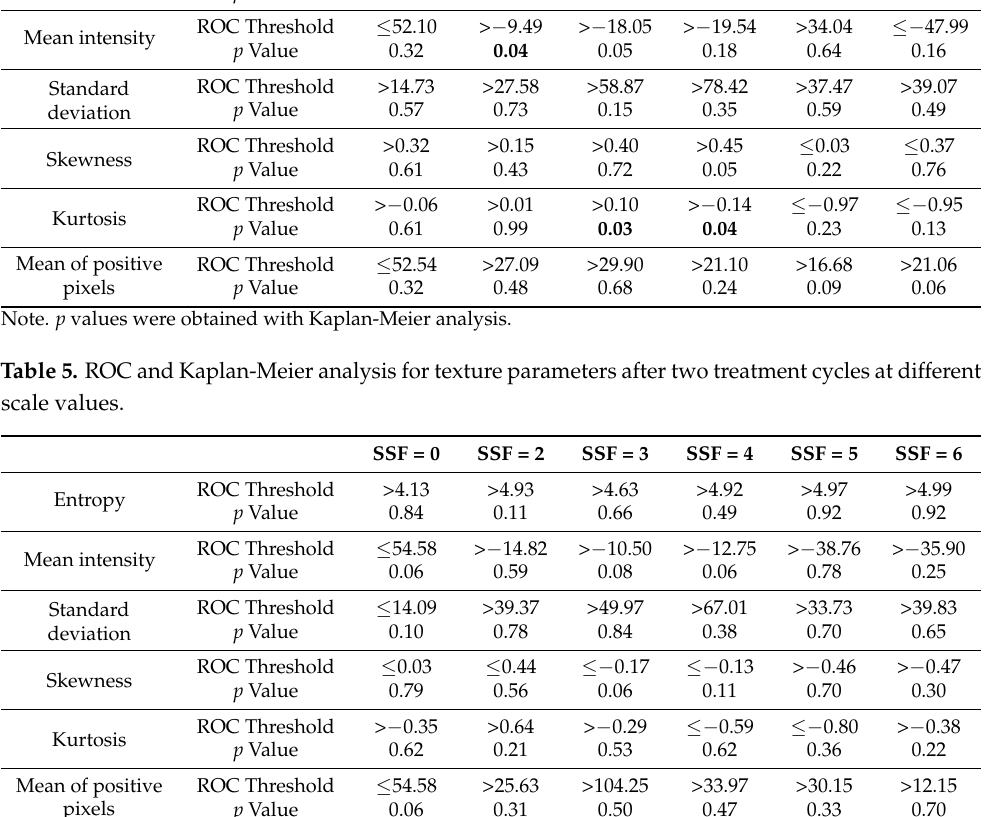
scale (SSF2, p value = 0.033 and p value = 0.016, respectively), and percentage change in MPP at medium texture scale (SSF4, p value = 0.016) were found to be independent prognostic factors for TTP (Table